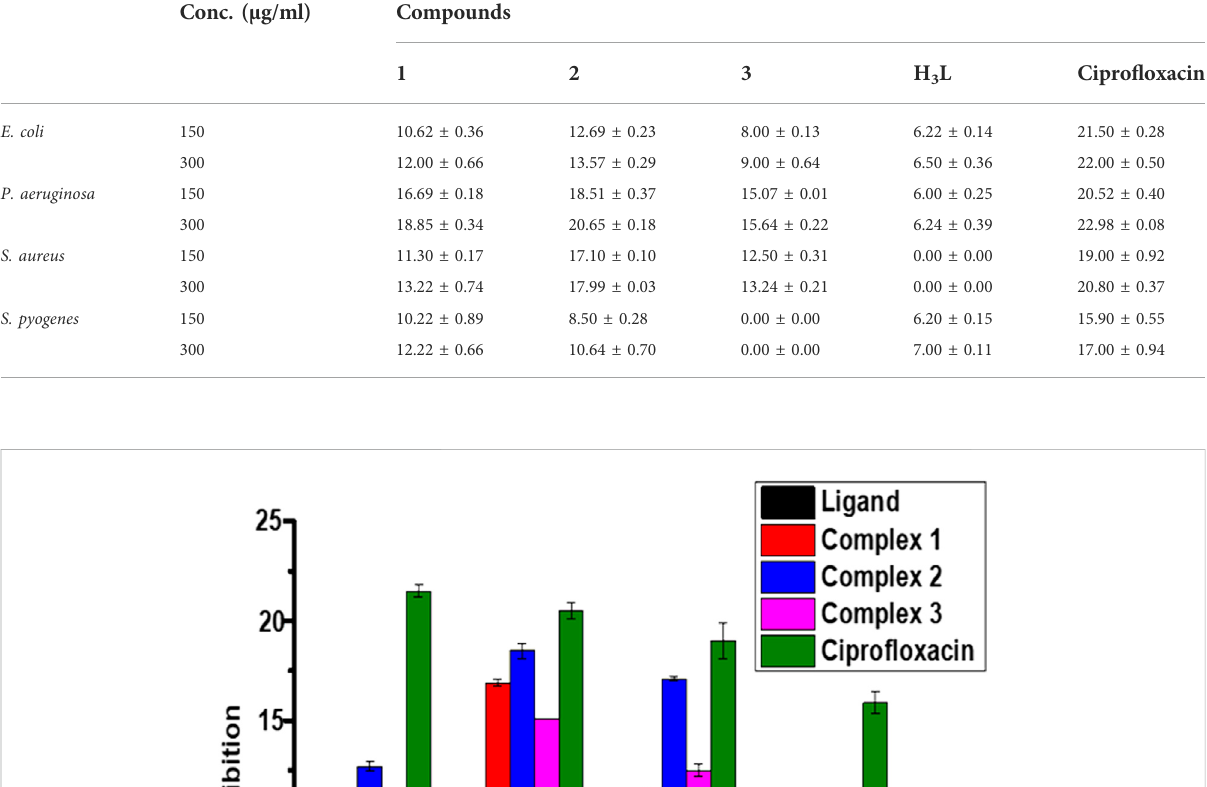
TABLE 5 Mean inhibition zone of bacterial growth in mm (mean ± SD).